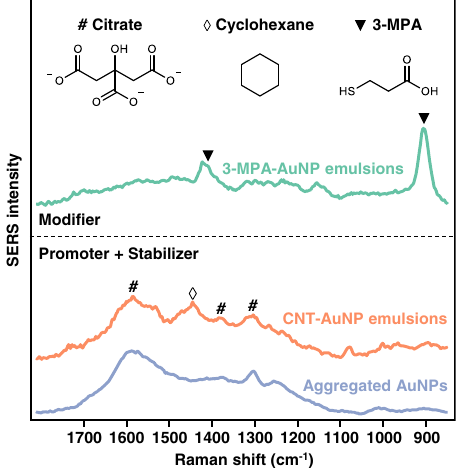
Fig. 2 | Surface chemistry of modi fi er-capped and modi fi er-free plasmonic emulsions. Surface-enhanced Raman spectroscopy (SERS) spectra obtained from 3-mercaptopropionic acid (3-MPA) modi fi ed AuNP emulsions (teal spectrum line), CNT-AuNP emulsions (rose spectrum line), and salt-aggregated AuNPs (ice blue spectrum line) in-situ. The spectra show that 3-MPA modi fi ers are adsorbed strongly to the AuNPs and alters their surface chemistry in the product emulsion while the surface chemistry of the AuNPs in emulsions formed with the combina- tion of ionic promoters and particle stabilizers remain